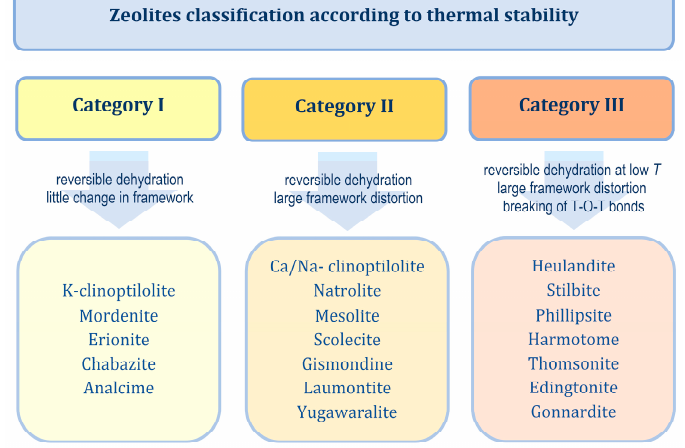
Figure 6. Zeolites classified according to thermal stability [74].